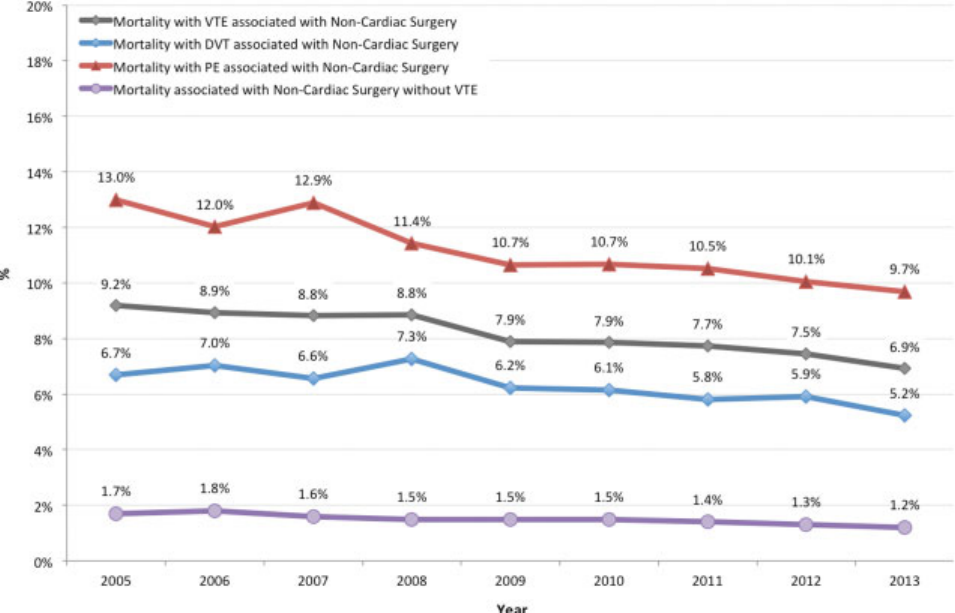
Fig. 3 In-hospital mortality trends among patients with perioperative venous thromboembolism. p -Value for trend < 0.001.